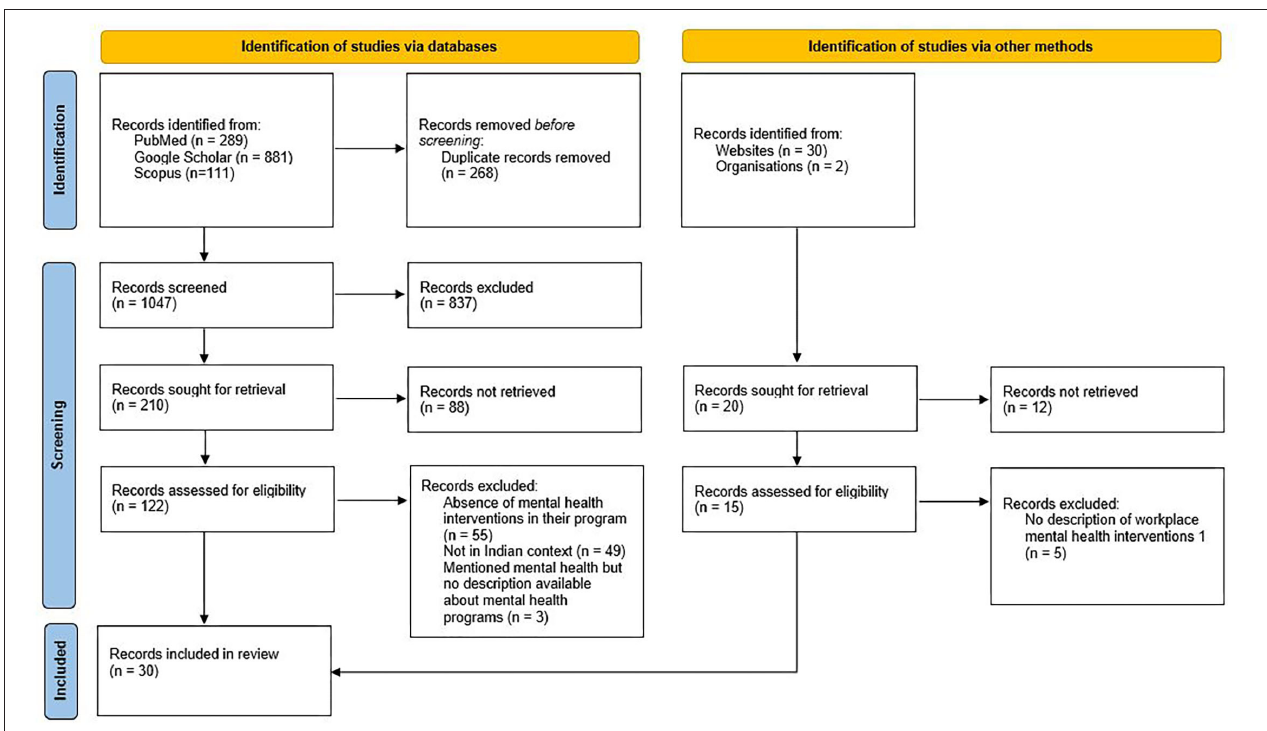
FIGURE 1 | PRISMA flow diagram of the study.